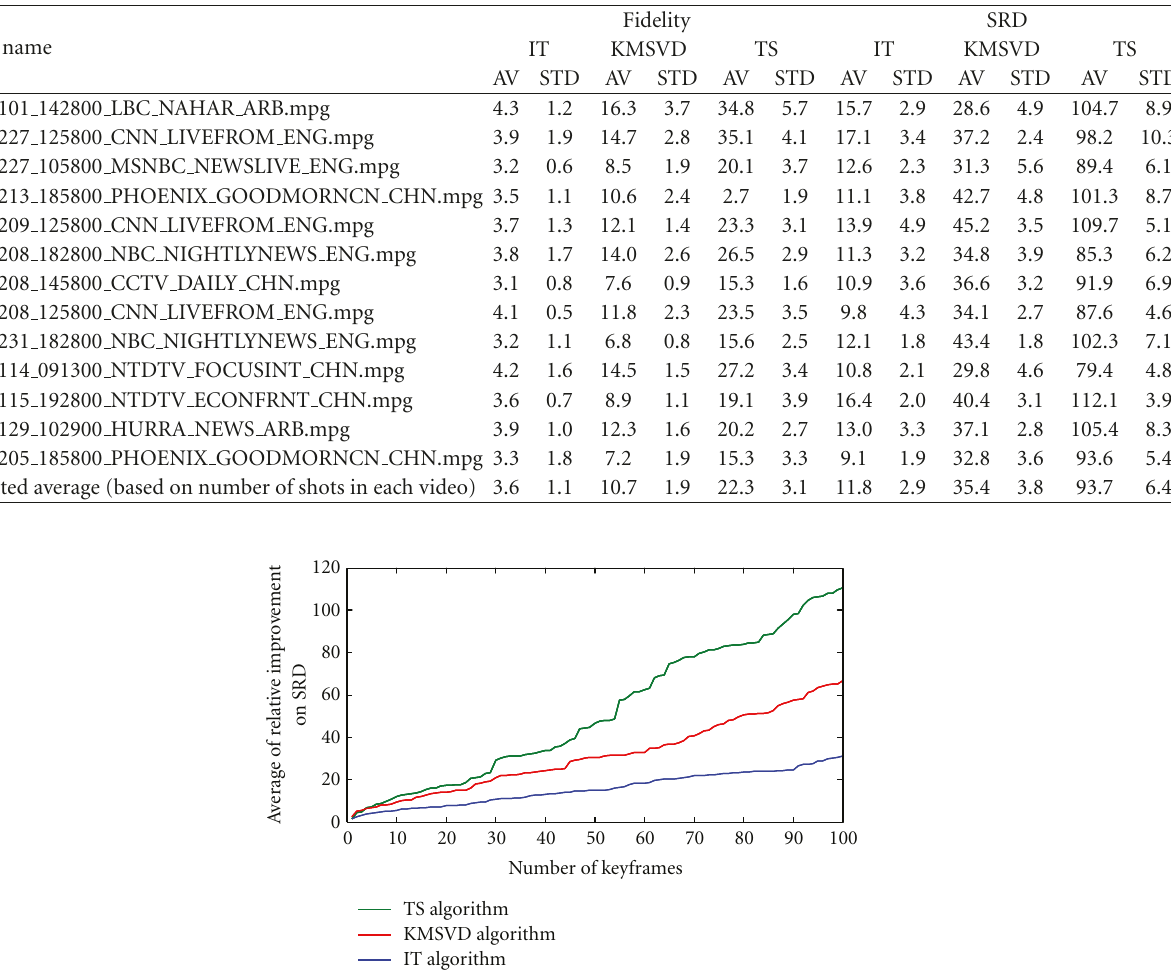
Table 2: Average (AV) and standard derivation (STD) of the relative improvement ( Δ ) measured on the fidelity and SRD results of the proposed algorithm with respect to each of the other algorithms using all the videos of TRECVID 2006.